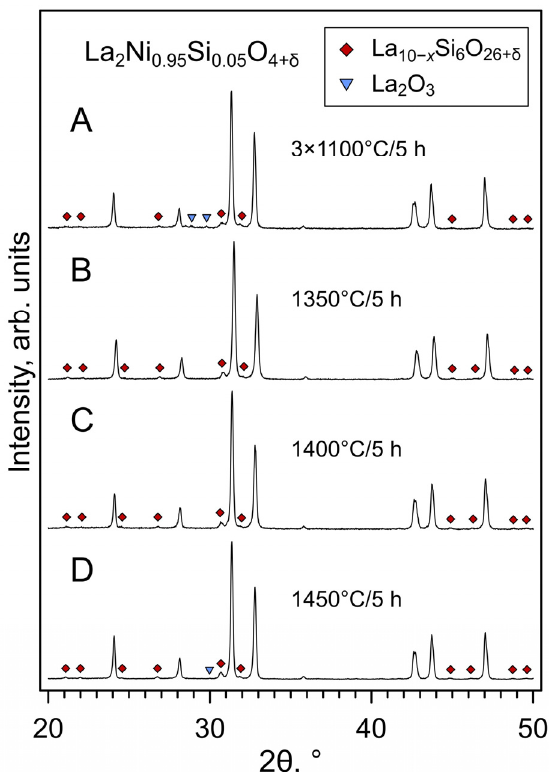
Figure 1. XRD patterns of La 2 Ni 0.95 Si 0.05 O 4+ δ samples after thermal treatments: ( A ) powder and ( B – D ) compacted samples sintered at different temperatures.